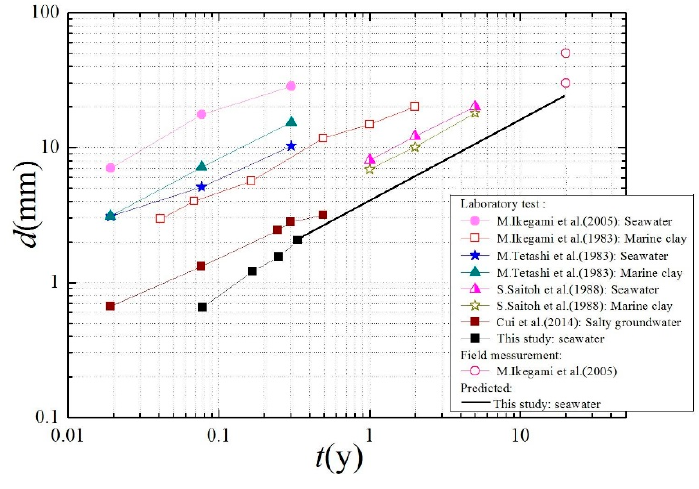
Figure 9. Variations of deterioration depths of different soil-cements with age.